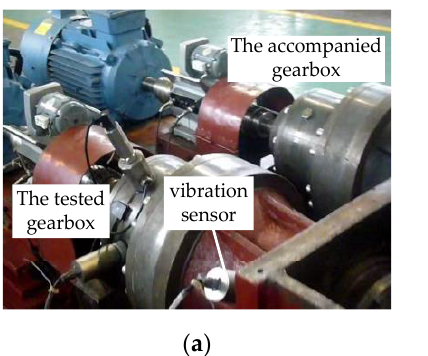
Figure 13. The structure of the pitch drive.